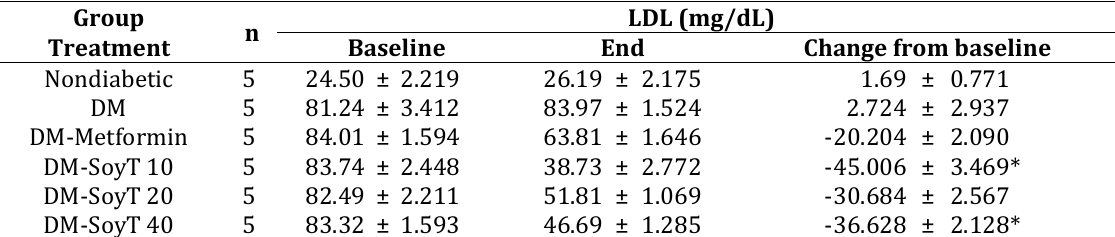
Table V. LDL levels after 3 weeks of treatment